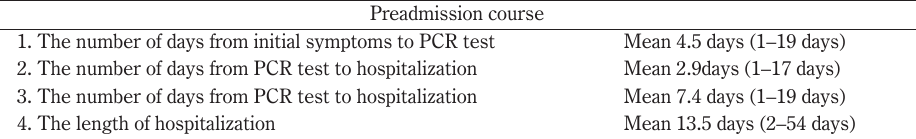
Table 4 Preadmission course of COVID-19